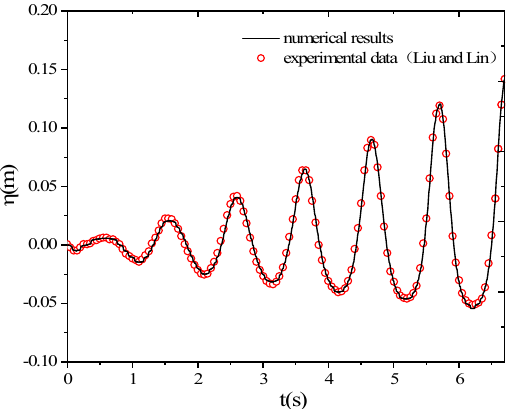
Figure 9. The validation of the free surface time history curve, experimental data (Liu and Lin) from [12].